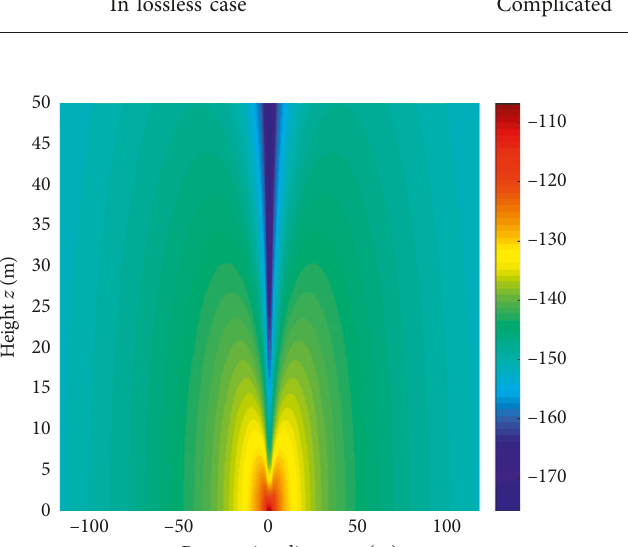
Figure 9: Spatial distributions in 􏽢 ρ − 􏽢 z plane of the DR terms of the magnetic field component | B the presence of N -layered regions.